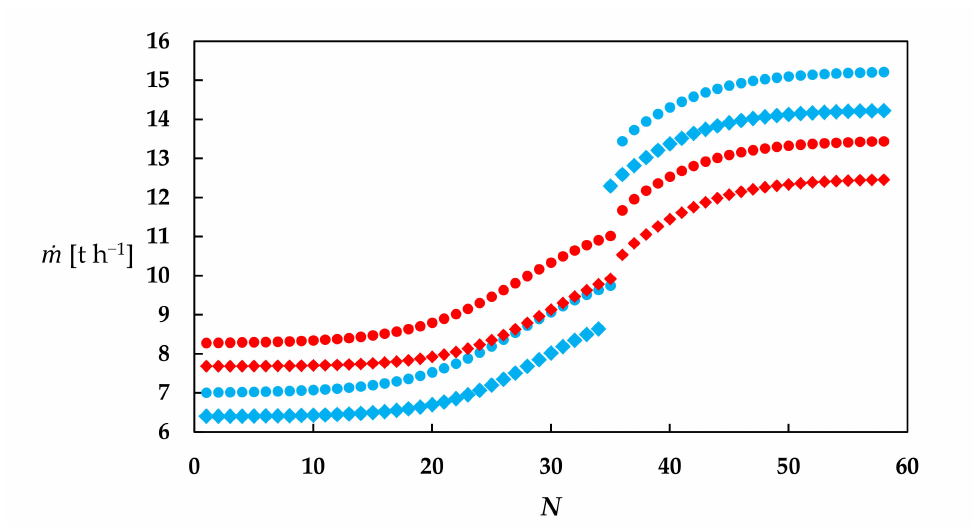
Figure 5. Ethyl acetate separation column flow rate profiles; diamonds—conventional process (column C2 in Figure 2); circles—conventional process with an MVRHP (column C2 in Figure 4); blue—liquid flow; red—vapor